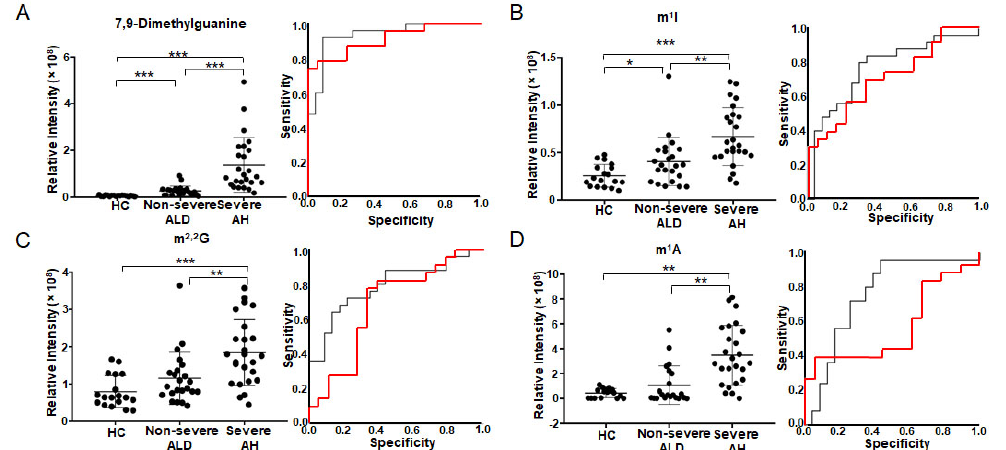
Figure 1. Modified nucleosides/bases with significant abundance change in urine detected by untargeted metabolomics using 2DLC-MS. The scatter plot on the left shows the abundance of 7,9- dimethylguanine ( A ), m 1 I ( B ), m 2,2 G ( C ) and m 1 A ( D ) in urine. The plot on the right shows the ROC analysis results. The red curve shows the ROC analysis results of HC vs. non-severe ALD. The AUC of 7,9-dimethylguanine ( A ) is 0.911, p < 0.001 and 95% CI = 0.824–0.998. The AUC of m 1 I ( B ) is 0.710, p = 0.022 and 95% CI = 0.553–0.867. AUC of m 2,2 G ( C ) is 0.677, p = 0.057 and 95% CI =